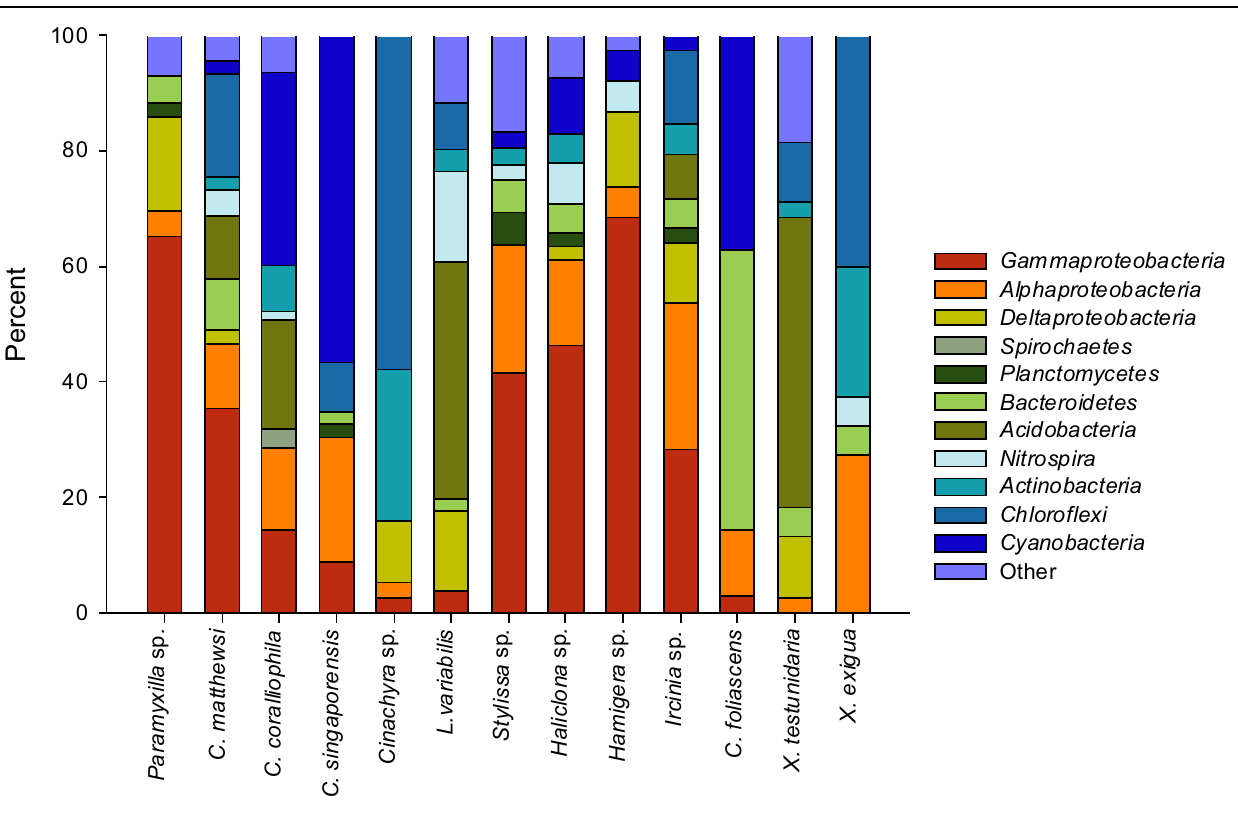
the specific nature of GBR sponge-bacterial populations was the finding that all species (with the exception of Hamigera